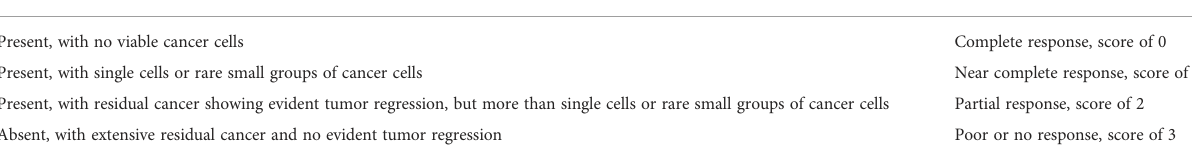
TABLE 1 Relationship between the treatment effect and tumor regression grade